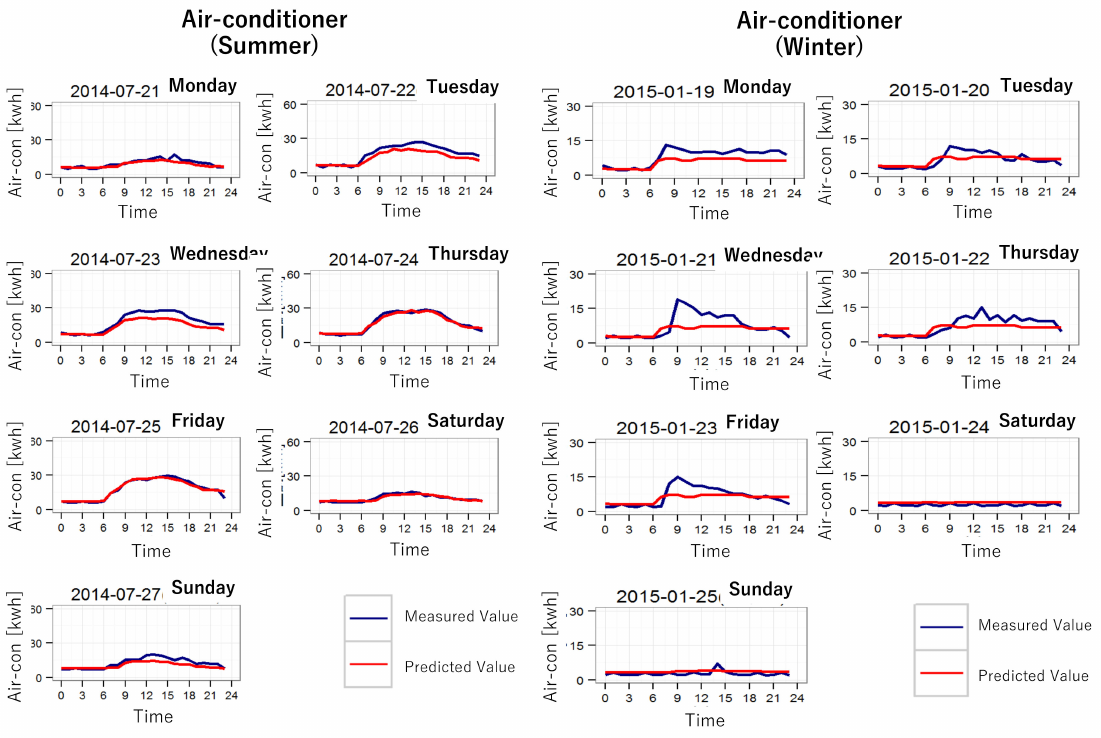
Figure 13. Results of the prediction for air-conditioners (summer and winter) by the EP tool.